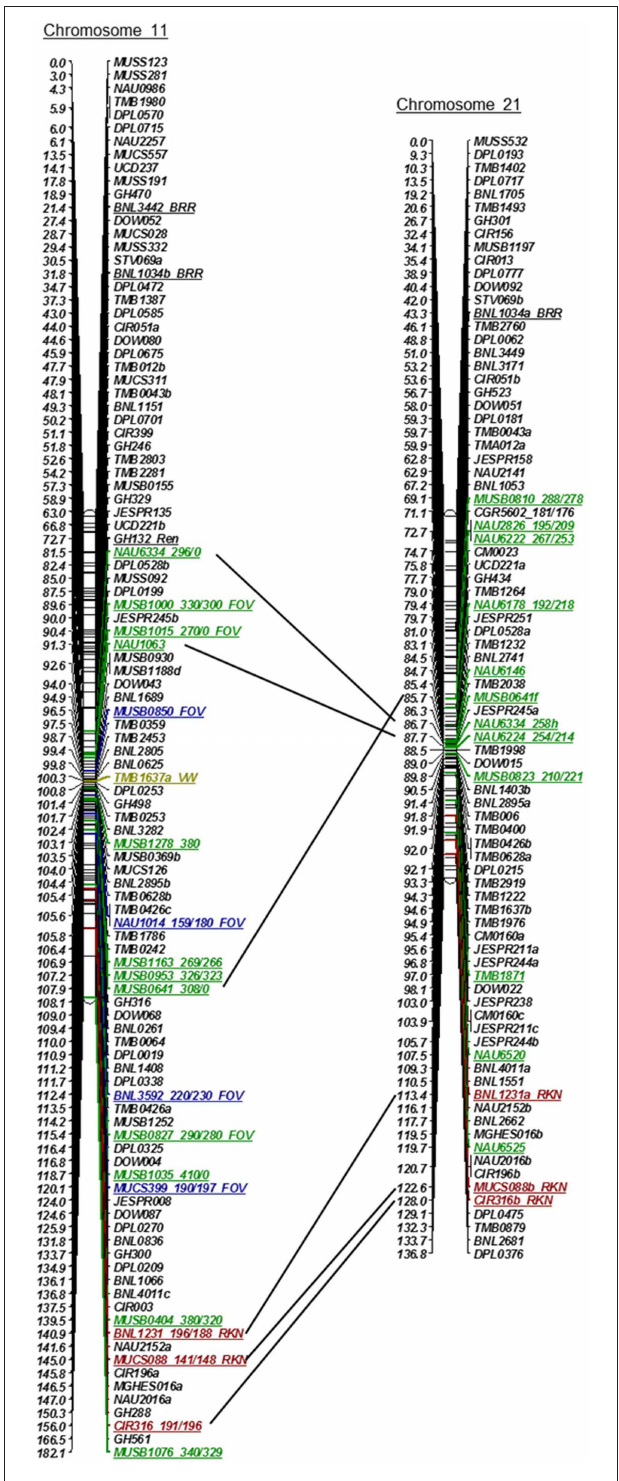
FIGURE 1 | Linkage maps of Chr 11 and its homoeologous Chr 21 using an interspecific [Upland TM-1 ( Gossypium hirsutum ) x Pima 3-79 ( G. barbadense )] RIL population (Yu et al., 2012), showing relationships between molecular markers and underlying QTLs involved in